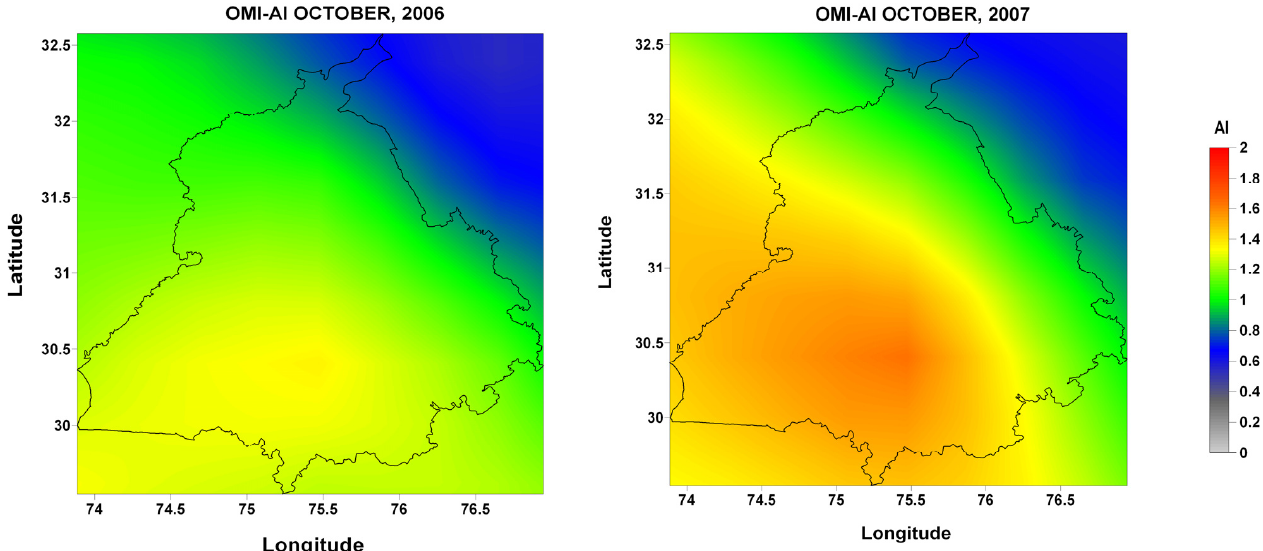
Fig. 9. Spatial variation of OMI-AI over Punjab state during October 2006 and 2007. Figure 10: